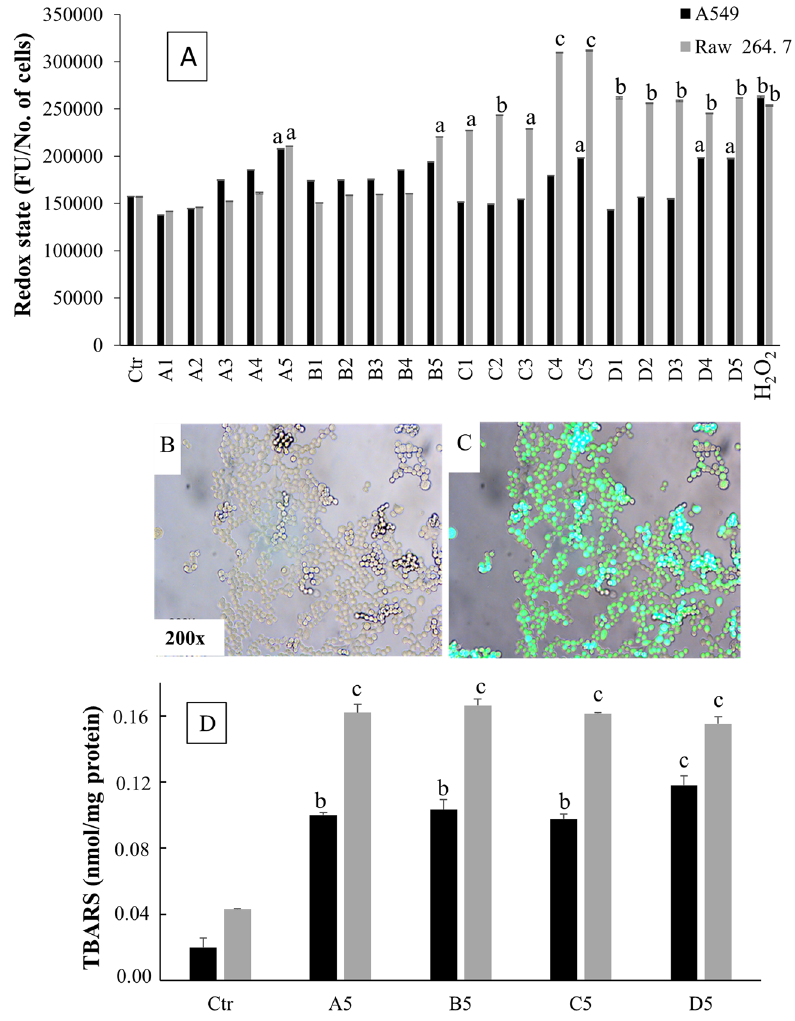
Figure 3. ( A ) Redox status assessed by means of DCF staining in A549 and Raw 267.4 cells. The redox status, expressed as intensity of DCF fluorescence, was evaluated in the two cell lines, either untreated (Ctr) or exposed for 3 h to varying concentrations either of slag powders with varying granulometry (A1–A5, B1–B5, C1–C5) or of untreated asbestos (D1–D5). H 2 O 2 (100 µ M) was tested as a positive control. The results are expressed as the average of fluorescence (FU)/number of cells and are the means ± SD of three independent experiments. Statistical analysis: a P < 0.05, b P < 0.01, and c P < 0.001 vs . control. ( B , C ) Representative microphotographs showing the effect of slag powders in Raw 267.4 cell lines, either unstained ( B ) or loaded with DCFH-DA ( C). ( D ) TBARS levels, expressed as nmol/mg protein, in A549 and Raw 267.4 cells after contact for 12 h with the highest concentrations either of slag powders (15.62 µ g/cm 2 ) of different granulometries ( A – C ) or of asbestos. ( D ) The columns report the means + SD of triplicate analyses. Statistical analysis: b P < 0.01 and c P < 0.001 vs .